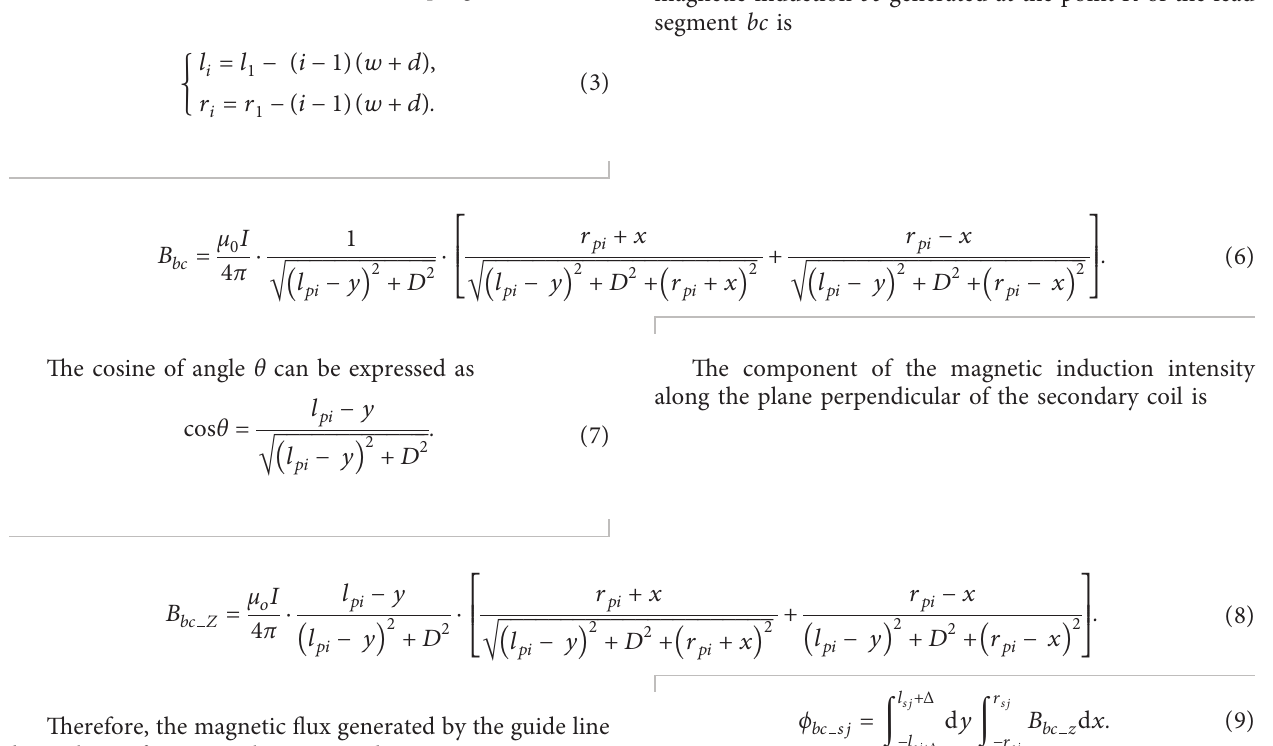
Figure 3: Simulation model of coupling